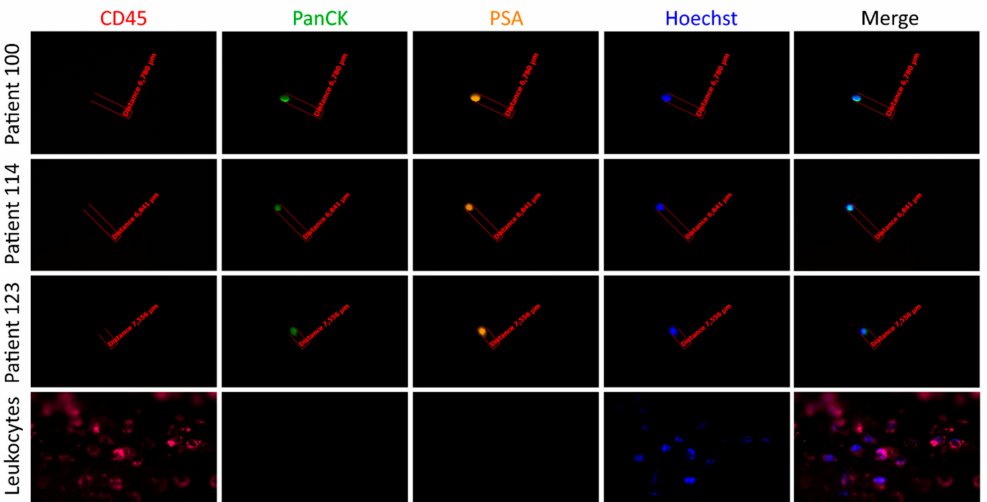
Figure 4. Detection of CTCs captured by the CellCollector ® in vivo system. Representative images of CTCs isolated in vivo and non-specifically bound leukocytes (CD45-positive). The cells were identified as tumor cells according to the following criteria: panCK-positive (green), CD45-negative (red) and optionally, PSA-positive (orange). The nucleus was stained with Hoechst 33258 (blue). The images were obtained using a fluorescent microscope (Carl Zeiss, Axio Imager 2, 20 × ) and analyzed with the Carl Zeiss, Axio Vision 4.8 software.